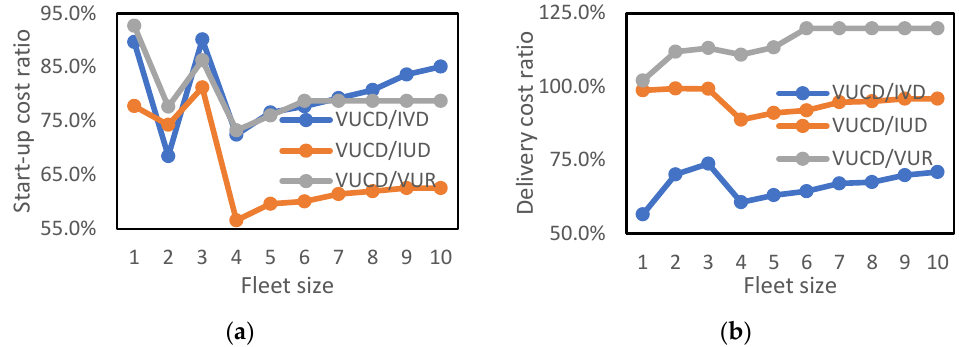
Figure 8. Start-up cost and delivery cost of different models. ( a ) Start-up cost ratio; ( b ) Delivery cost ratio.